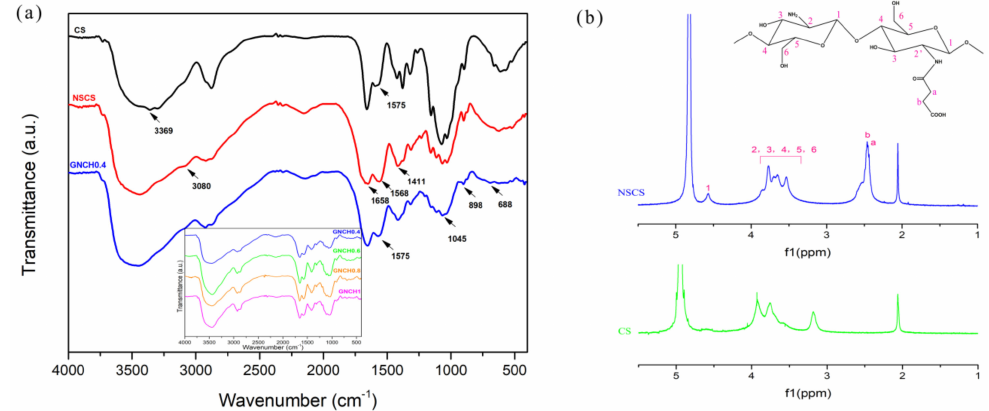
Figure 2. ( a ) FTIR spectra of chitosan (CS), N -succinyl-chitosan (NSCS), GNCH. Inset: FTIR spectra of GNCH (0.4–1). ( b ) Structural formula and 1 H NMR spectra of CS and NSCS.